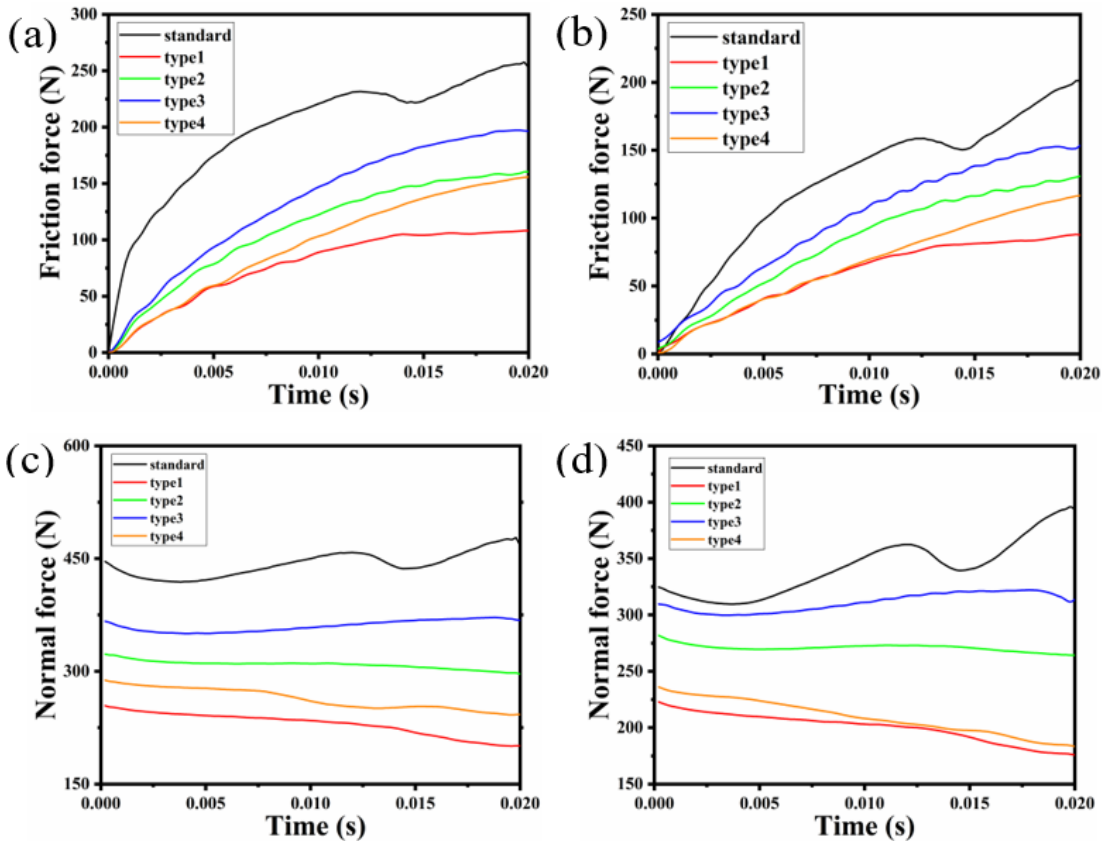
Figure 14. Contact friction force curve of ( a ) contact pair 1 and ( b ) contact pair 2. Contact normal force curve of ( c ) contact pair 1 and ( d ) contact pair 2.